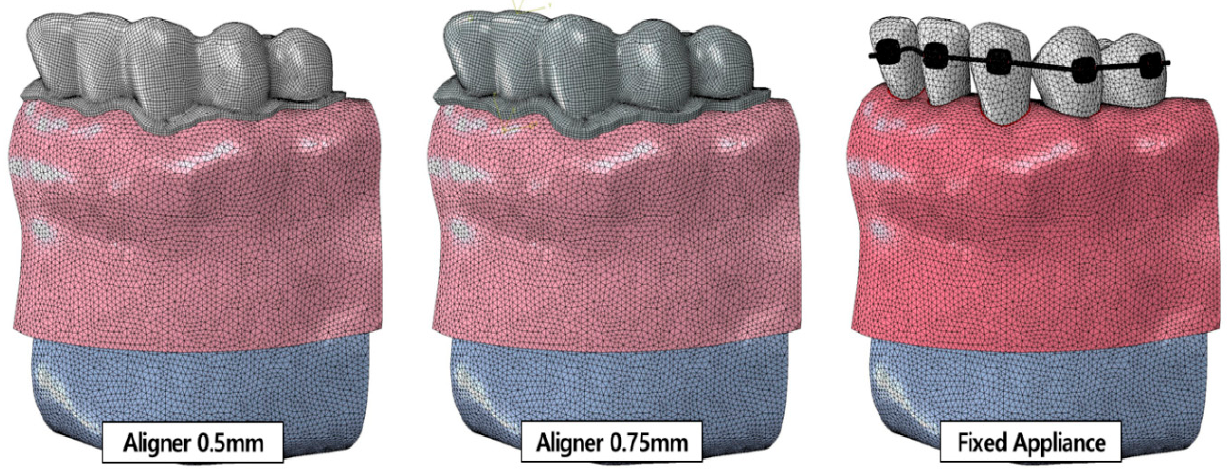
Figure 5. Orthodontic treatment finite element models. ( left ) 0.5-mm and ( center ) 0.75-mm-thick transparent aligners; ( right ) tooth-alveolar model of mild crowding dentition with a fixed appliance.